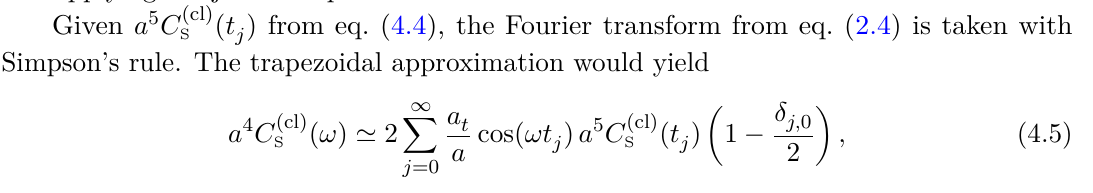
from eq. (5.1) on the spatial extent L = aN of s sph c